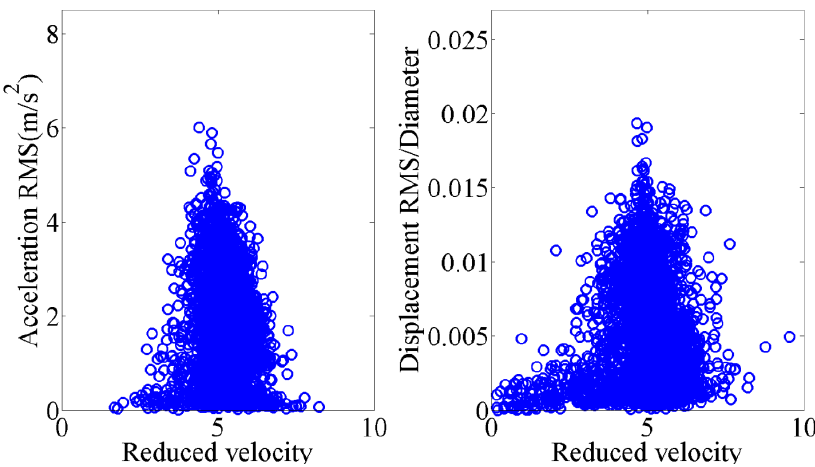
Figure 11. Vibration response versus reduced velocity in April.